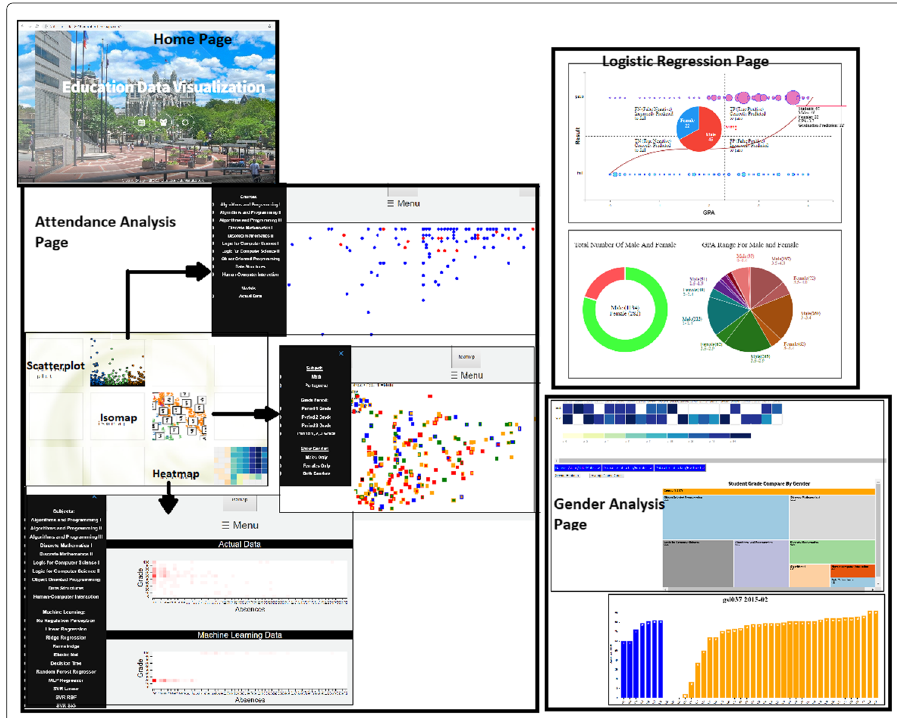
Fig. 1 Academic performance visual analysis web-page available on "http://fall-2018-education.herokuapp. com/". The system provides a set of tools: scatter plots for attendance vs. grades; Isomap projection for role of parents education; Heatmap Matrix visualization for machine learning approaches and predictions; Gender analysis comparing grades for male and female students. Using a drop down menu, users can make selections on different algorithms. Using radio buttons, they can select courses, semesters, periods, and